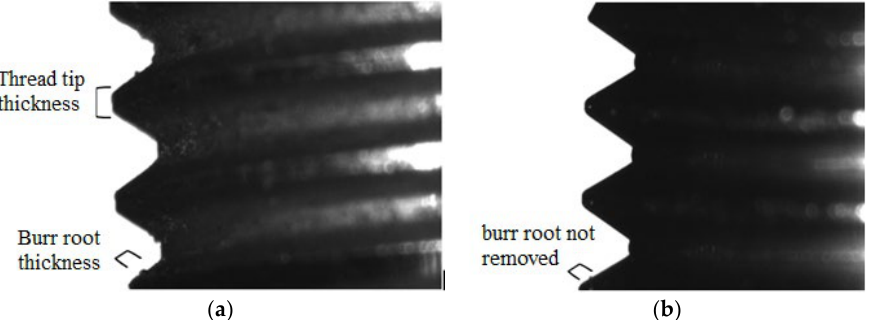
Figure 6. The thickness of the root of the burr is more than 1/4 of the thickness of the thread tip: ( a ) before processing; ( b ) after processing when small burrs are removed; the root of the large one remains, and the top of the thread is preserved.